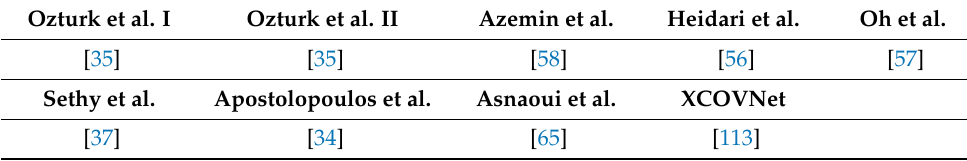
Table 12. Methods (X-axis) for the Figure